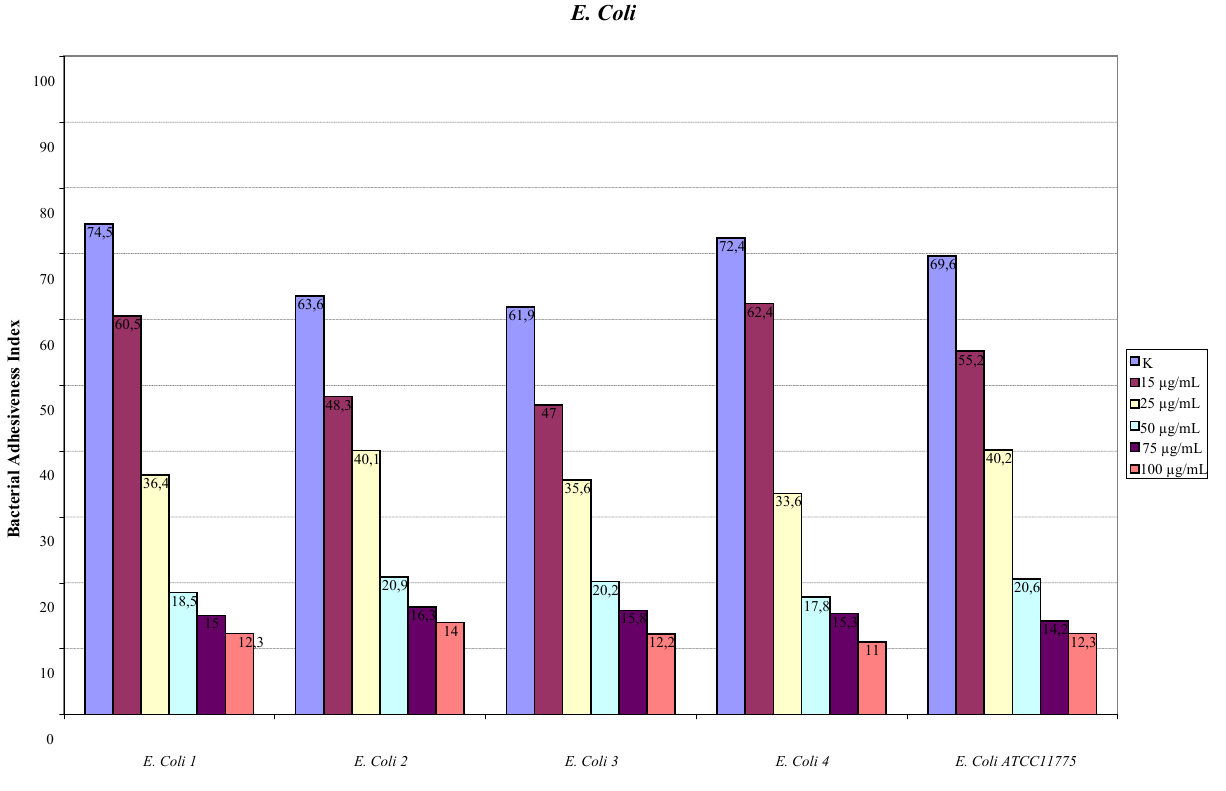
Figure 1. Adhesion indexes for the strains of E. coli . E.